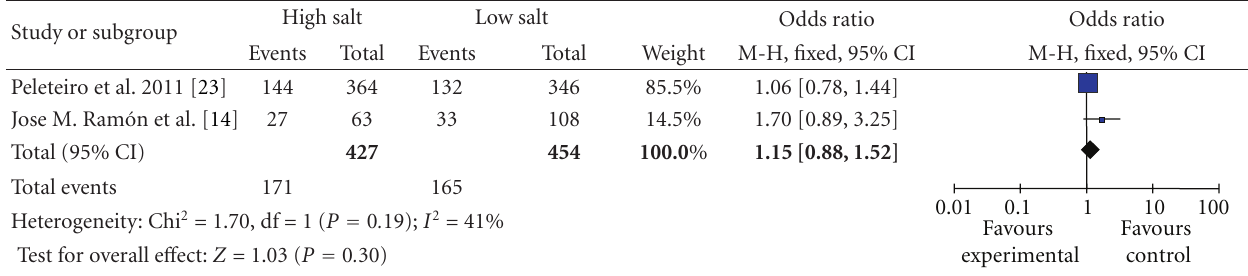
Table 4: High versus low categories of salt and gastric cancer in Europe.